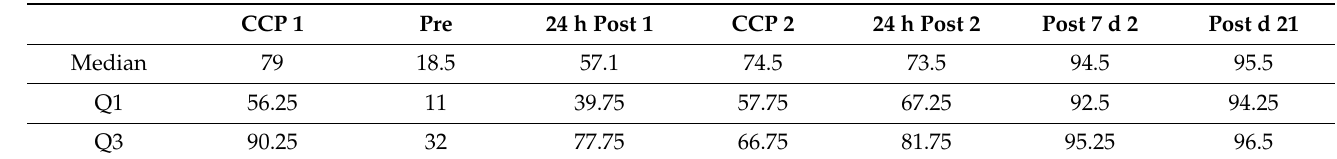
Table 3. Distribution of percentage inhibition across time in 4 patients who received two CCP infusions due to morbid obesity. Values listed are percentage inhibition.